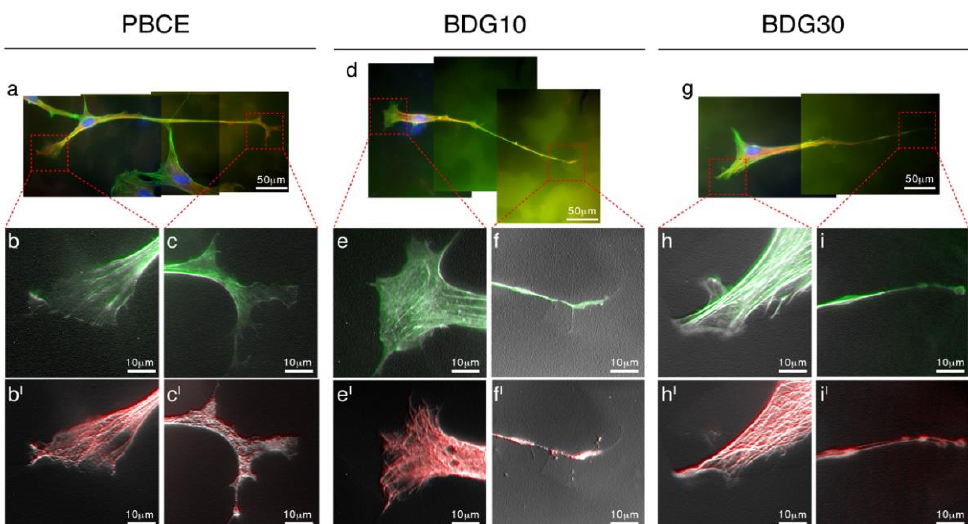
Figure 4. Coordinate nucleation of F-actin and Microtubules drives the hBM-MSCs’ shape on PBCE, BDG10 and BDG30. ( a , d , g ) Representative fluorescence images of hBM-MSC in proliferation medium in the absence of FBS (F-actin [FITC-phalloidin, green], Microtubules [human anti-tubulin antibody, red], and nuclei [DAPI, blue]). Due to the length of the cells, the images include 2 / 3 microscope frames. Elaboration of selected details (( b , c , b I , c I ); ( e , f , e I , f I ); ( h , i,h I , i I )) revealed the coordinate action of F-actin and tubulin in building the new cytoskeleton architecture of the cell as a consequence of the seeding on polymer